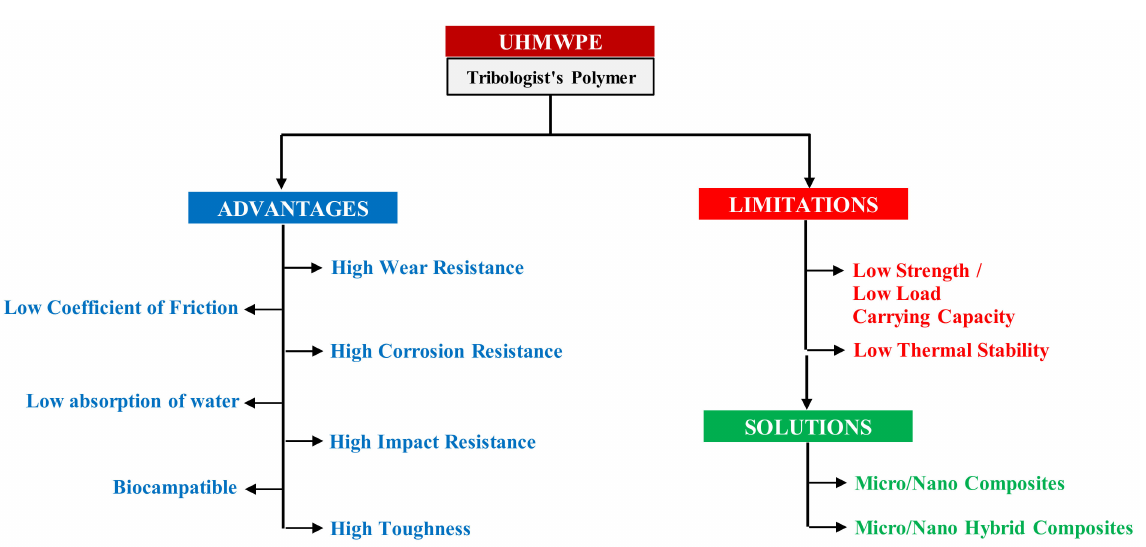
Figure 2. UHMWPE as a Tribo-Material: Advantages, Limitations and